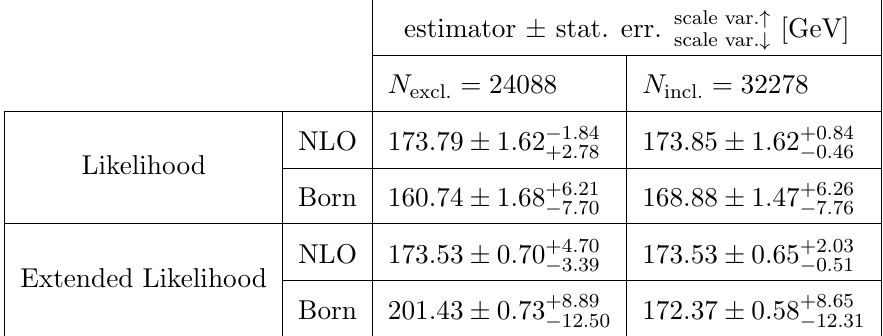
Table 3 . Extracted top-quark mass estimators from NLO t -channel